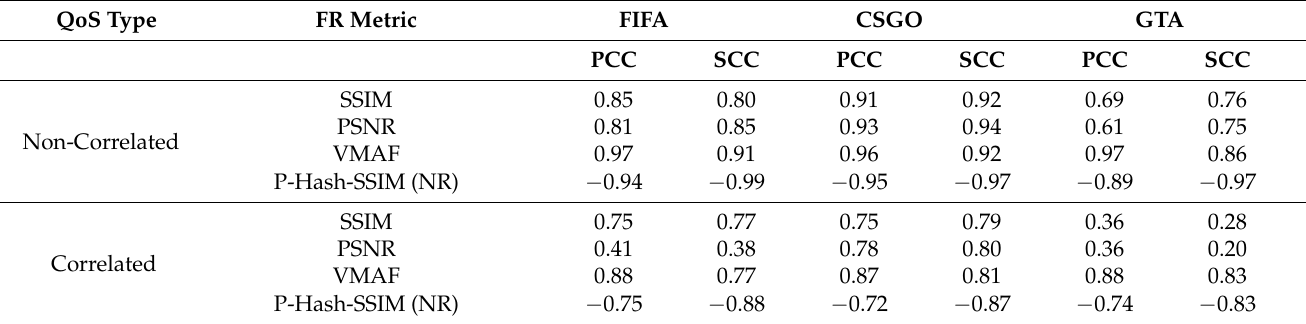
Table 2. PCC and SCC of Full-Reference Objective QoE Metrics against the subjective MOS. QoS